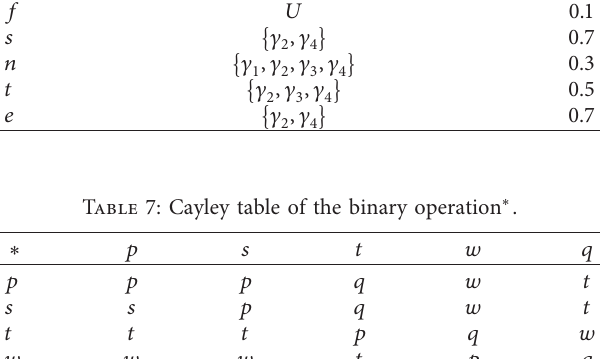
Table 6: Table representation of hybrid structure 􏽥 g